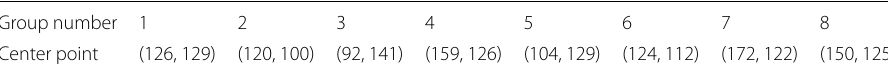
Table 1 Coordinates of the theoretical matching center point